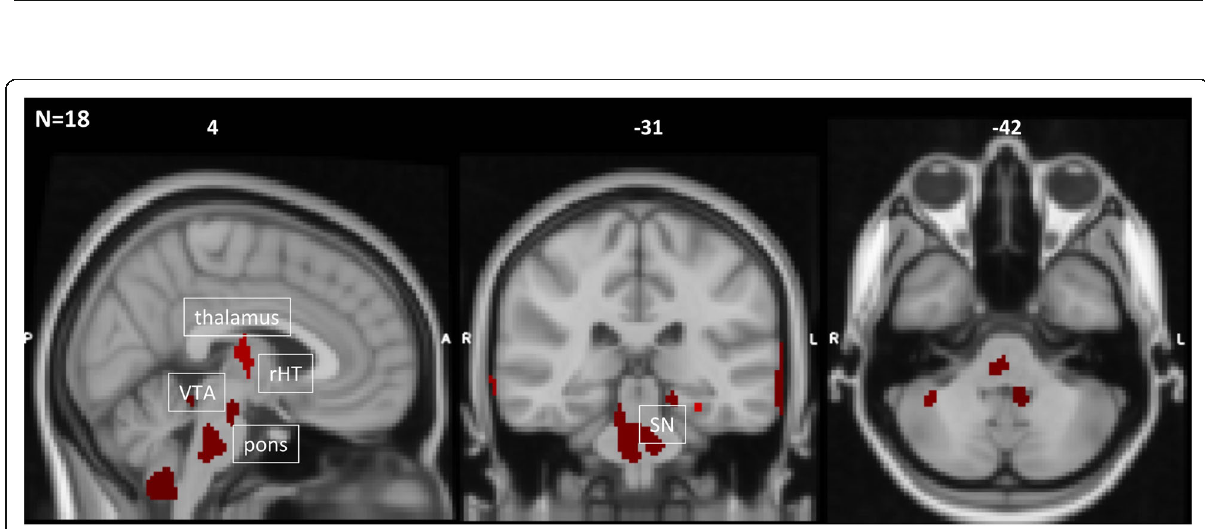
Fig. 4 Local increases (red) and decreases (blue) in CBF across all CH prior to GONB in comparison to healthy controls. Brain areas in red include cerebellum and hippocampus. Clusters in blue colour corresponds to OFC, primary auditory cortex, insula and MTG. For these contrasts, data included one CBF map per patient and healthy individual. All clusters are significant at p < 0.05 (FWE corrected; initial height threshold set to 0.001)